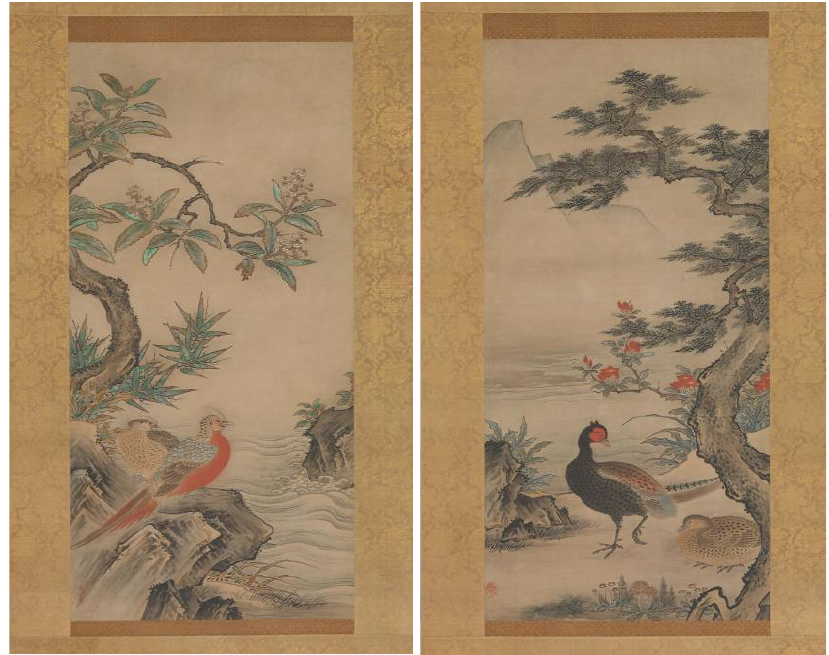
Figure 1. Kanō Shōei (1519–1592 狩野松栄 ). Pheasants among Trees: Flowers of the Four Seasons (ca. 1560s). Pair of hanging scrolls; ink, color, and gold on paper. Metropolitan Museum of Art, New York. Public